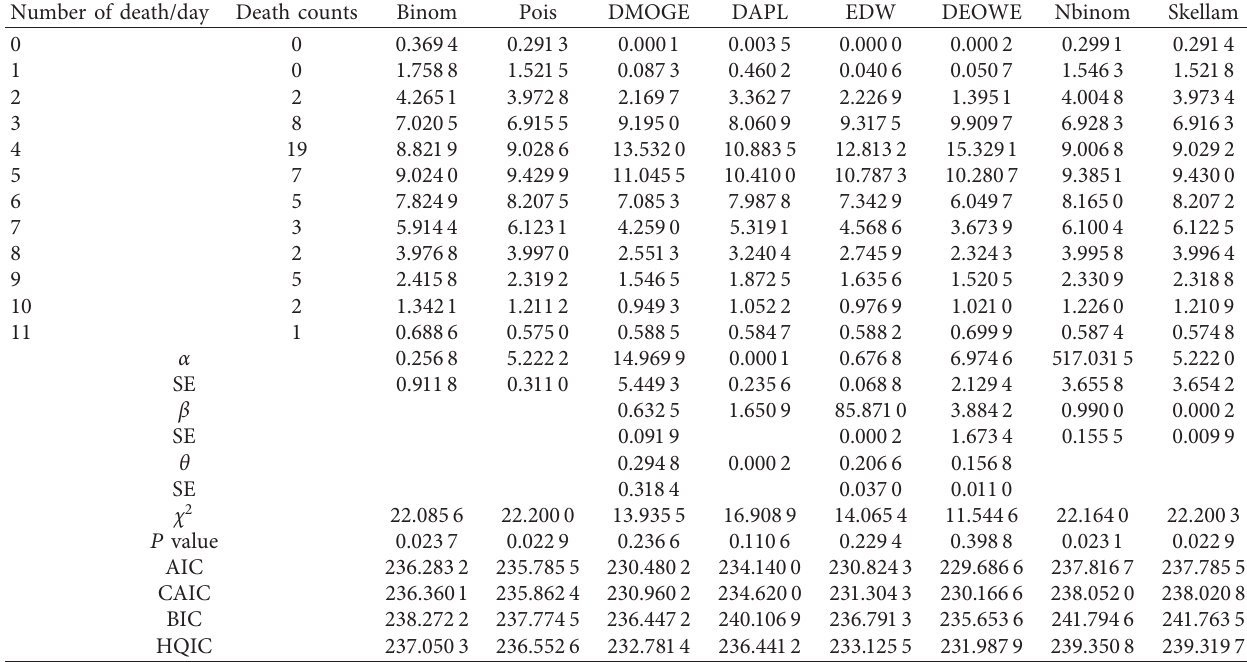
Table 6: MLE and standard error SE for models and goodness-of-fit criteria for each